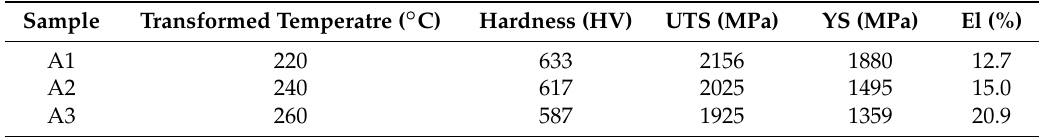
Table 1. Mechanical properties of isothermally-transformed samples.